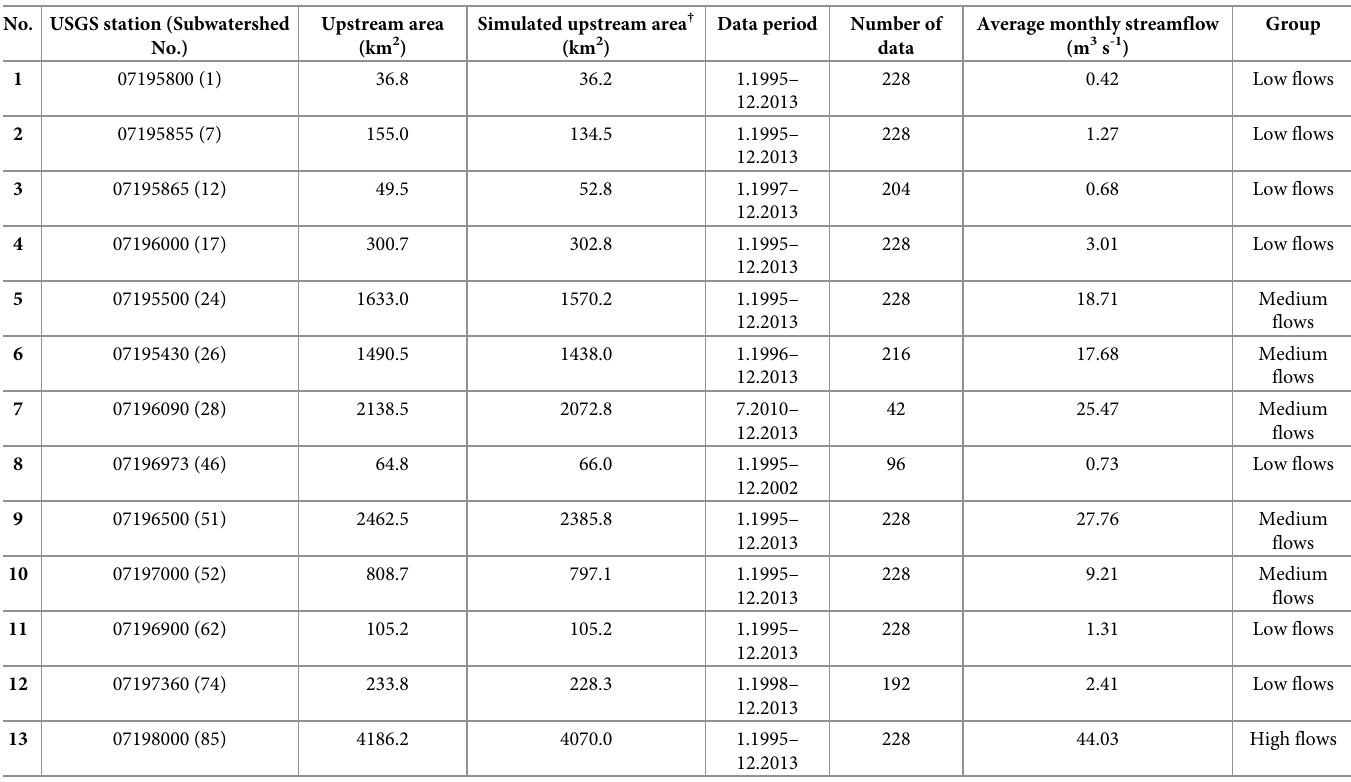
Table 1. Watershed properties of selected USGS stations. No. USGS station (Subwatershed